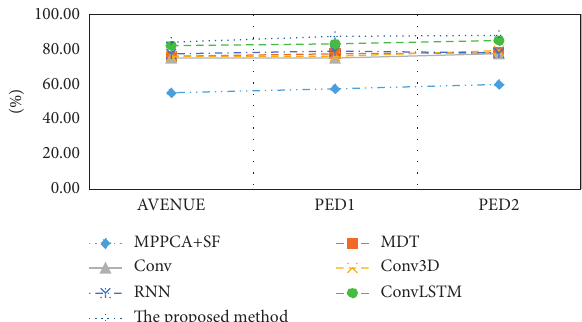
Figure 11: A comparison of experimental results between all methods and the proposed